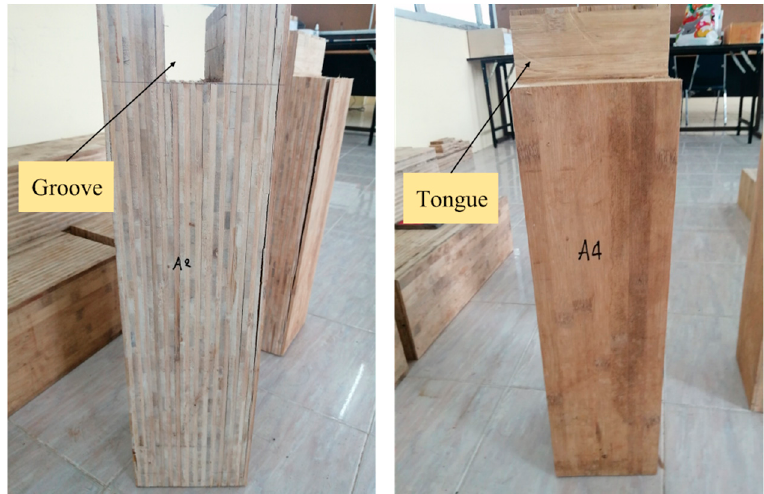
Figure 1. The TDG column cut to the groove and tongue.